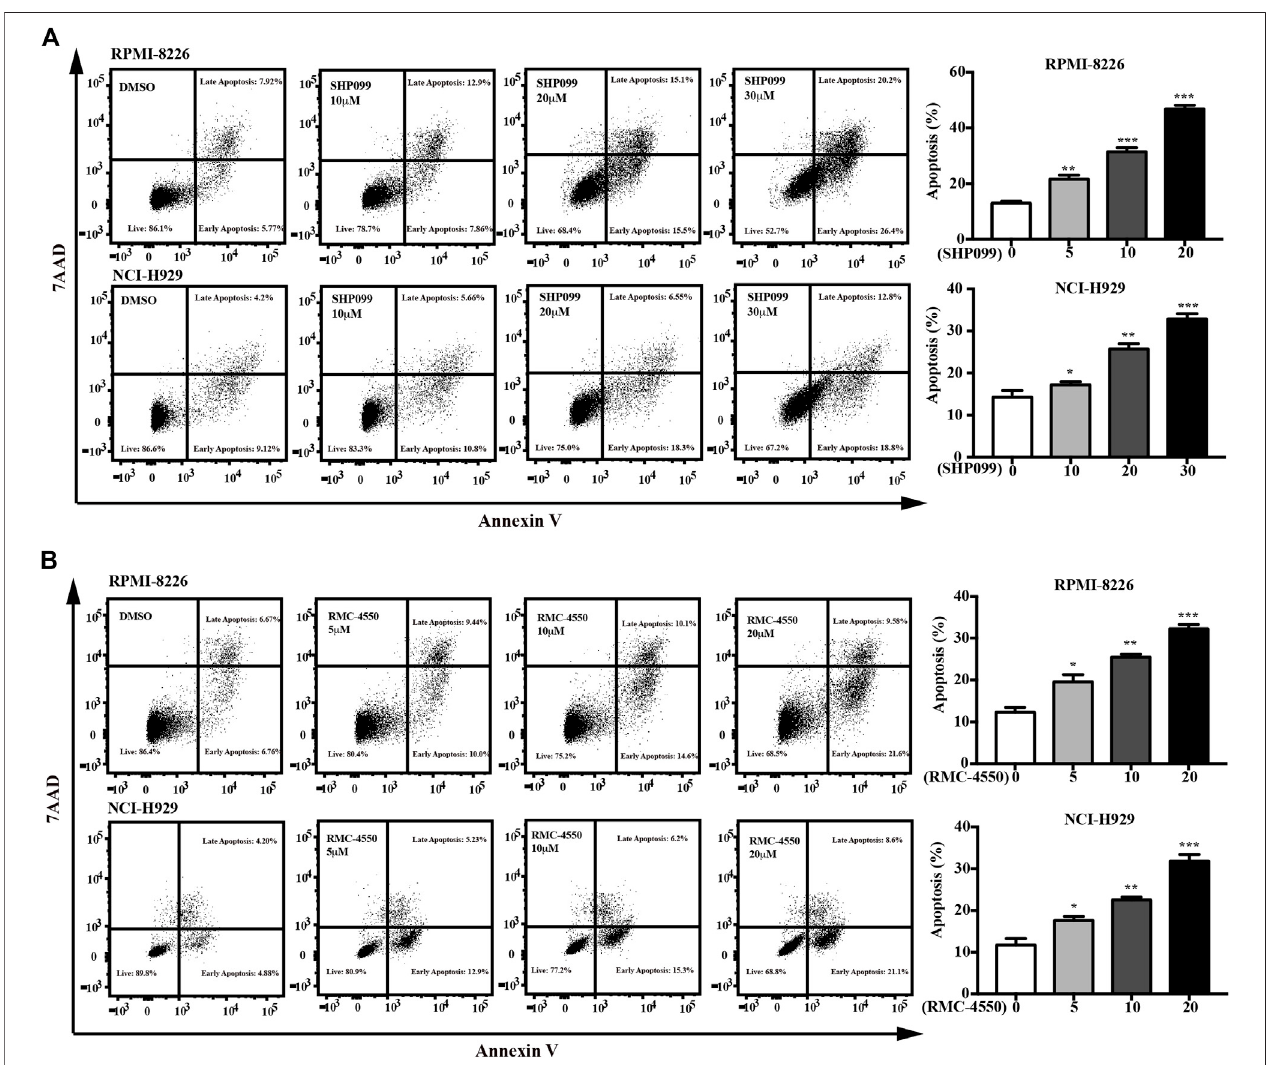
FIGURE 2 | SHP2 inhibitors trigger apoptosis in MM cells. (A) RPMI-8226 and NCI-H929 cells were treated with 1, 10, 20, and 30 μ M of SHP099 for 48 h; then, apoptotic rates were analyzed by fl ow cytometry. (B) RPMI-8226 and NCI-H929 cells were incubated with RMC-4550 (0~20 μ M) for 48 h, and apoptotic cells were detected via fl ow cytometric analyses. The results represent the mean ± SD of three independent experiments. * p < 0.05, ** p < 0.01, and *** p < 0.001.